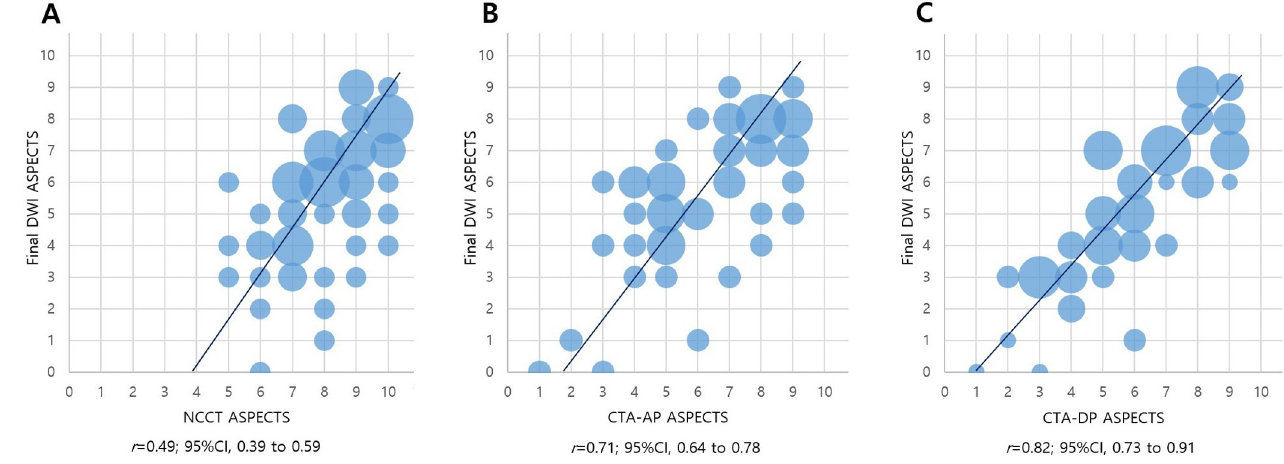
Fig 1. Correlation of ASPECTS on NCCT (A), CTA-AP (B), and CTA-DP (C) with final DWI ASPECTS.